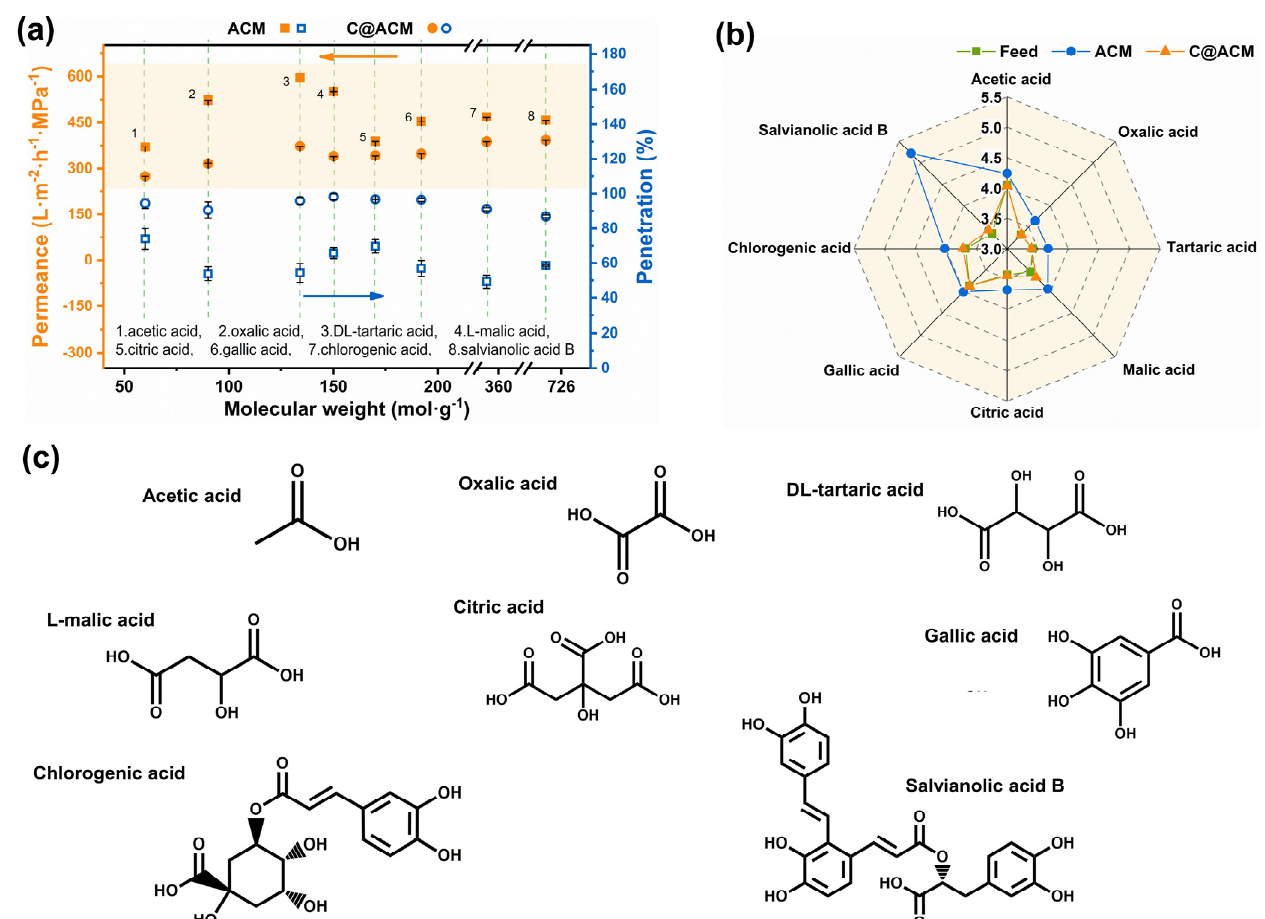
Figure 9. Permeation results of the nine acids through ACM and C@ACM: ( a ) permeance and penetration; ( b ) pH values of feed and permeation; ( c ) chemical structures of the eight acids.